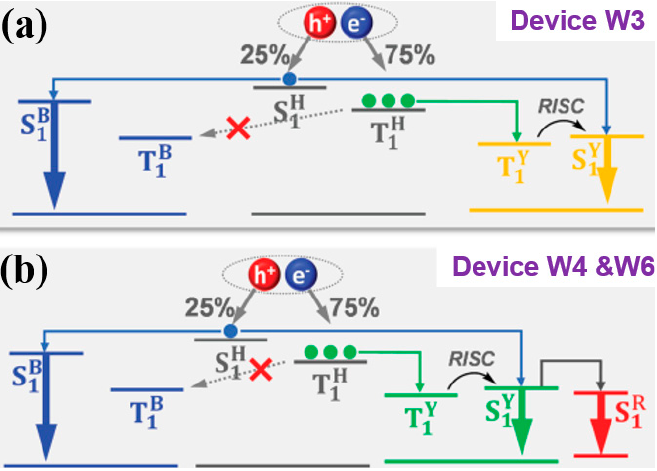
Figure 16. Device function mechanisms of the conceptual utilization of singlet and triplet excitons generated in EMLs. ( a ) Device W3, and ( b ) devices W4 and W6. H, B, Y, and R denote CBP, NI-1-PhTPA, PXZDSO2 and DBP, respectively. Reproduced from Reference